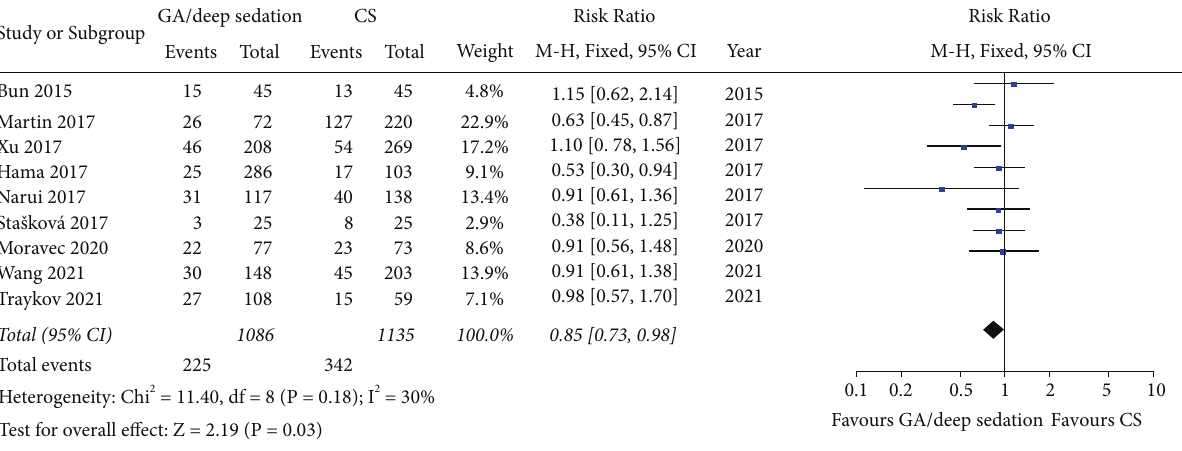
Figure 5: Forest plots comparing recurrence rates post-AF ablation between the GA/deep sedation group and the CS group.